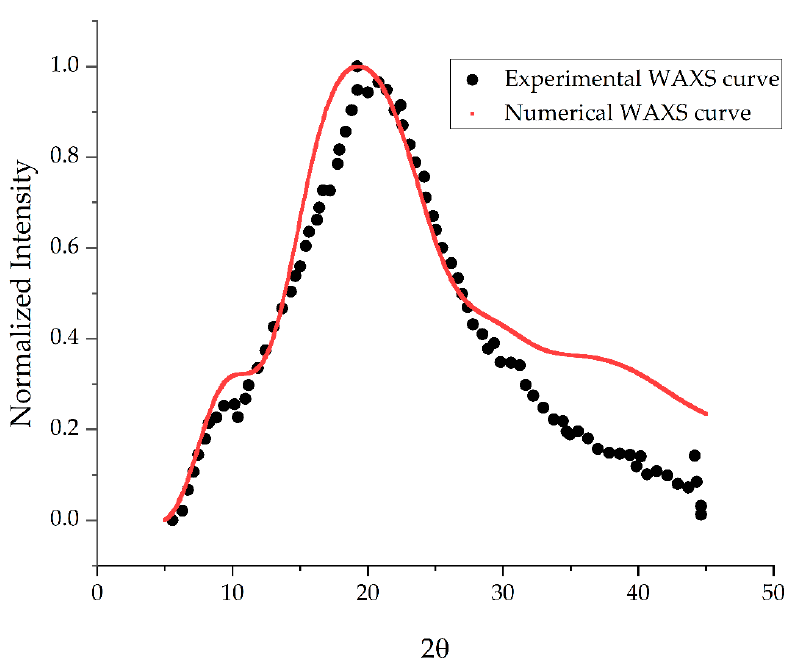
Figure 3. WAXS profile ( λ = 1.54178 Å) obtained in simulation compared with experimental one [52]. The main peak of the molecular model is at 19.39° being slightly different from natural dry gelatin (22.4°).